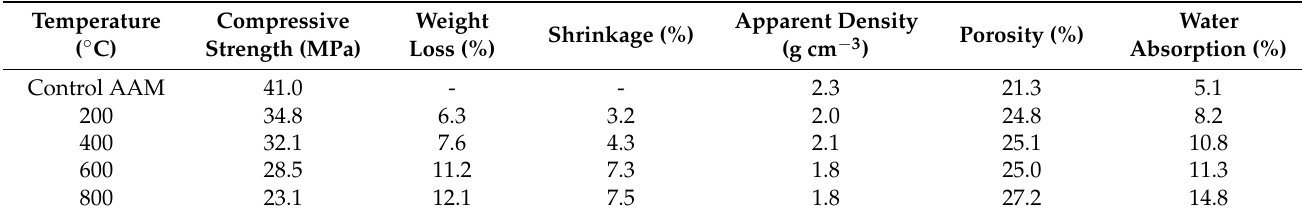
Table 5. Selected properties of LR90MK10 AAMs after firing at high temperatures.